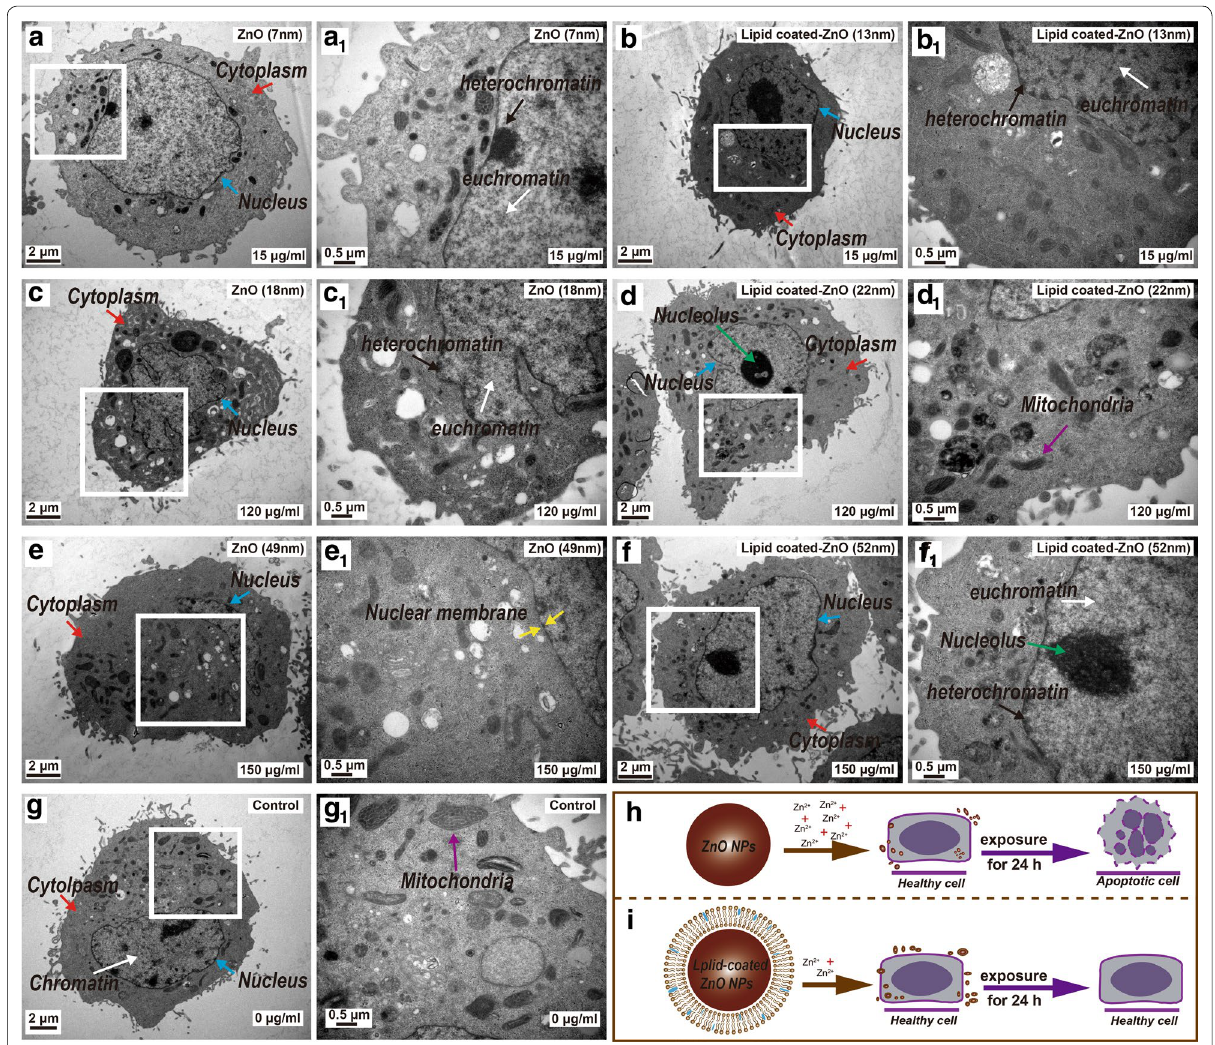
Fig. 11 The TEM images of the nucleus, nucleolus, cytoplasm, and the nuclear membrane morphology after being exposed to pristine ZnO NPs and lipid-coated ZnO NPs (0, 15, 120, and 150 μg/mL) for 24 h. The images in Panel ( a 1 – g 1 ) are enlarged from the panel ( a – g ). The blue arrows indicate the malformation of nuclear morphology after NPs exposure (nuclear membrane rupture). The black and white arrows indicate the chromatin condensation (electron-dense, black structure along nuclear membrane) within the nuclei. The images in panel ( h – i ) are simulated exposure process of